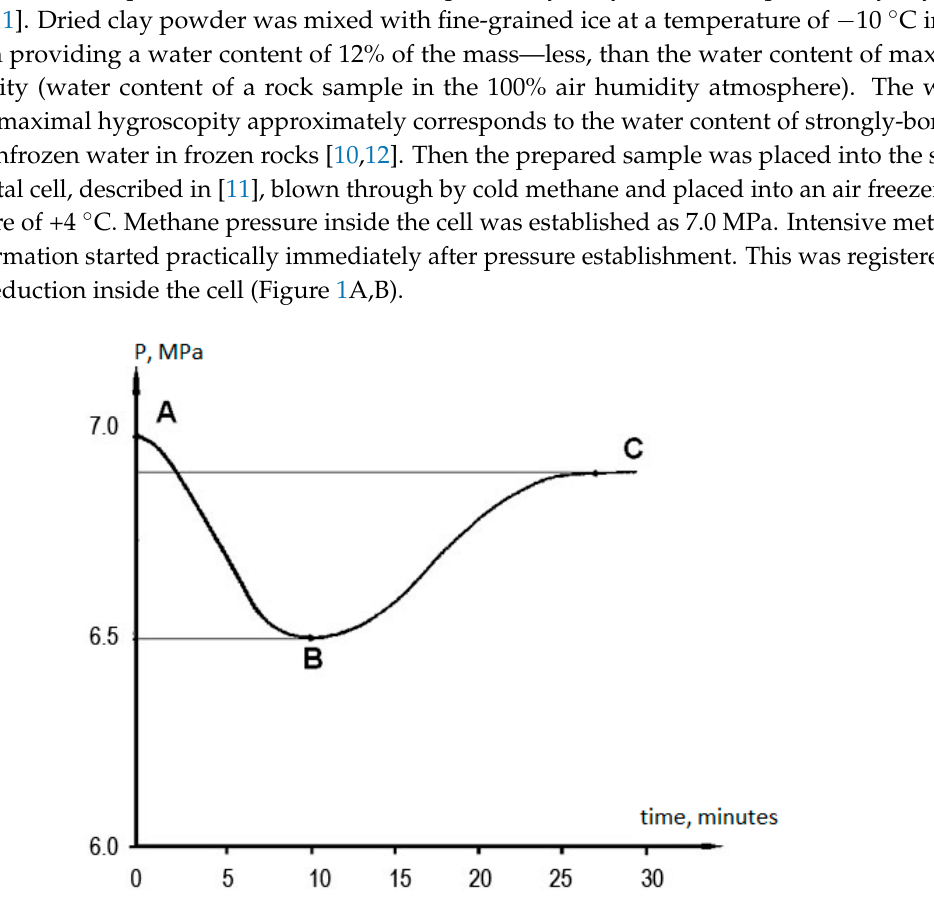
Figure 1. Pressure change with time when fine-grained ice decomposition in dry montmorillonite clay powder at hydrate formation conditions [11].